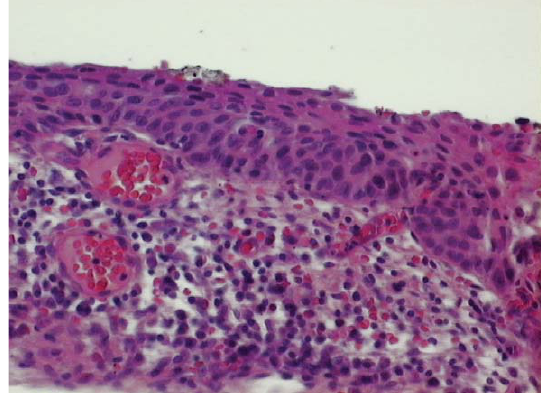
Fig. 1. CIN 3 non-recurring lesion.